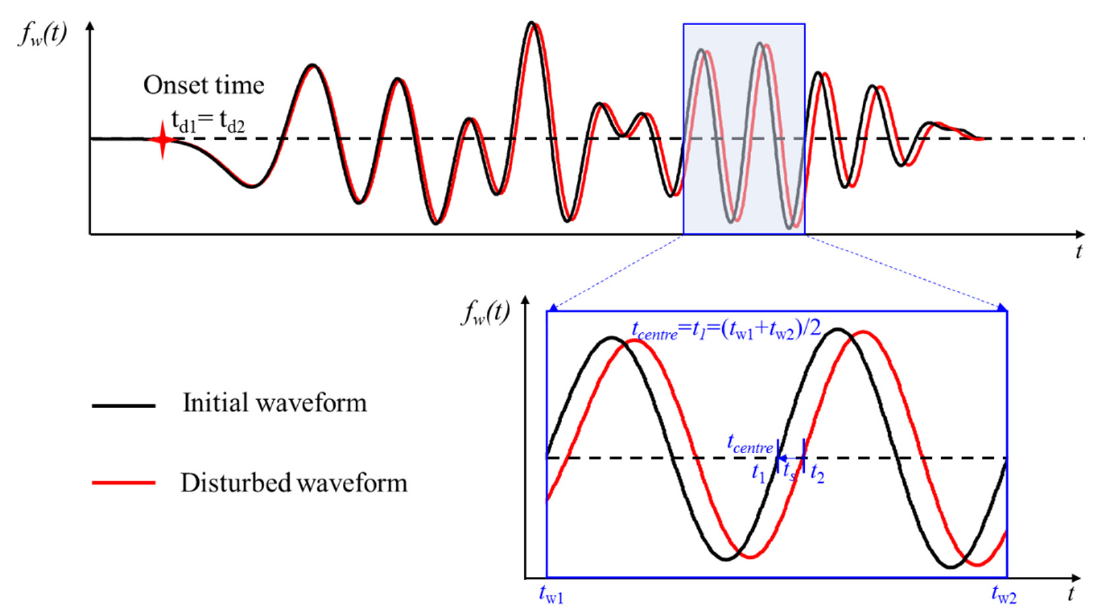
Figure 2. The received waveform before and after change when the medium changes slightly.